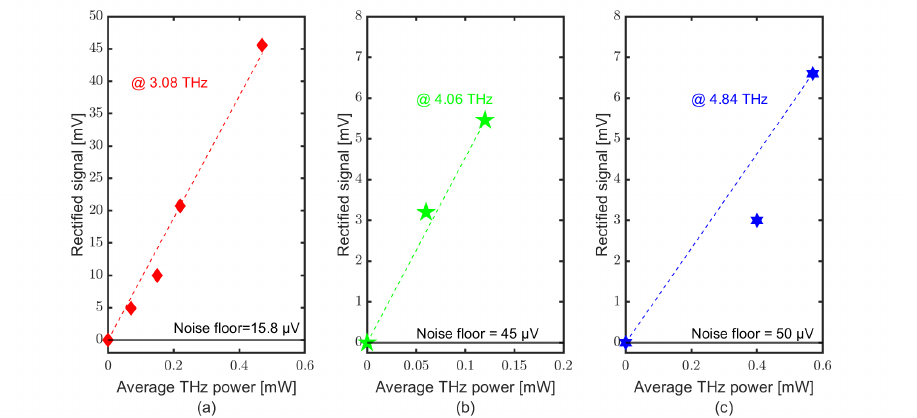
Figure 5. SD THz detector response with the FELBE as source at different frequencies and power using the lock-in measurement technique. ( a ) at 3.08 THz, ( b ) at 4.06 THz and ( c ) at 4.84